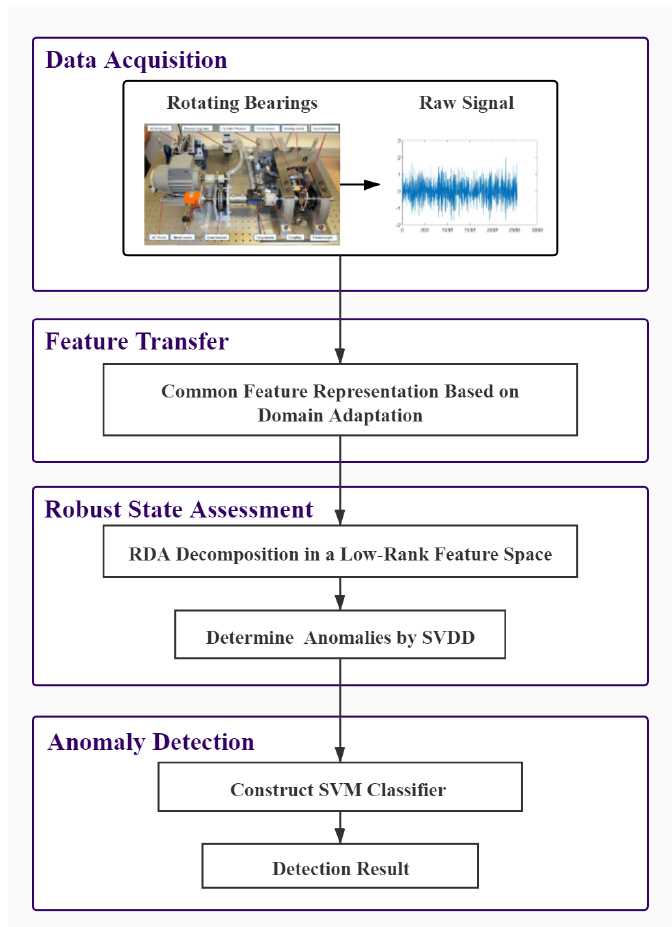
Figure 3. Total flowchart of the proposed robust detection method for bearing early